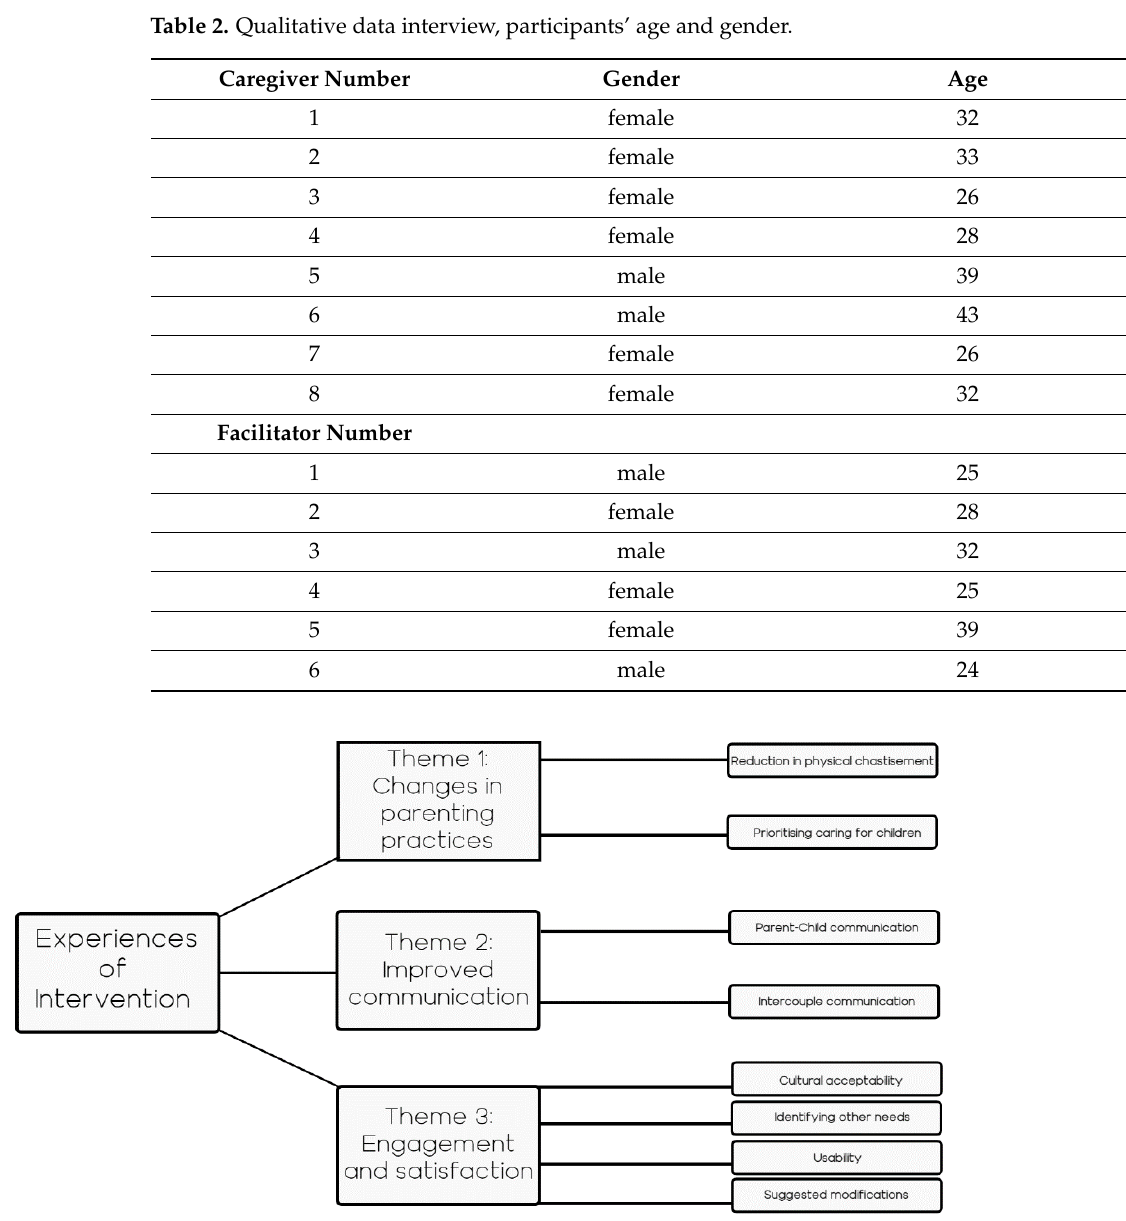
Figure 2. Thematic data map representing experiences with the Strong Families